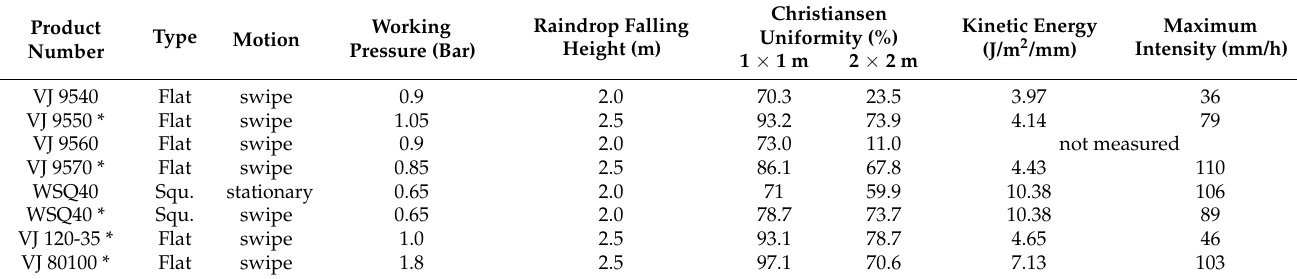
Table 1. List of tested nozzles. VJ—VeeJet nozzles provide a flat water jet. WSQ provide a square water jet. The nozzles marked with * are suitable for further use. The WSQ 40 nozzle was tested in a stationary position also with swipe. For VJ 9540 and VJ 9560 nozzles, Ke values were not measured, as the required uniformity of 70% was not achieved with these